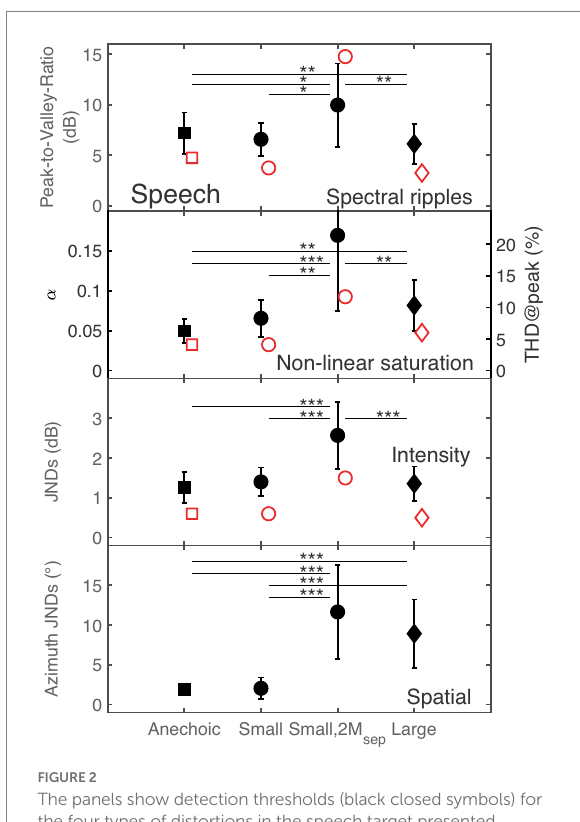
FIGURE 2 The panels show detection thresholds (black closed symbols) for the four types of distortions in the speech target presented without reverberation (Anechoic room), with mild reverberation (Small room), with mild reverberation and two maskers (Small,2M sep ), and with moderate reverberation (Large room). The rooms are represented by squares, circles, and diamonds, respectively. Here and in the following figures, statistically significant pair-wise comparisons based on levels of 0.05, 0.01, and 0.001 are reported by *, ** and ***, respectively. Red open symbols refer to predicted data. For non-linear saturation, in addition to the dimensionless parameter α , the right y-axis provides the THD@peak in